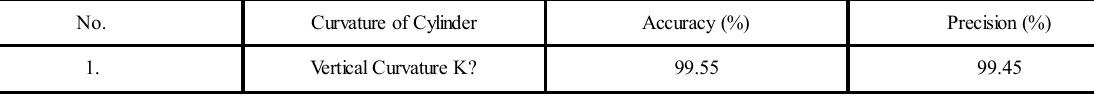
TABLE 6. ACCURACY AND PRECISION FOR